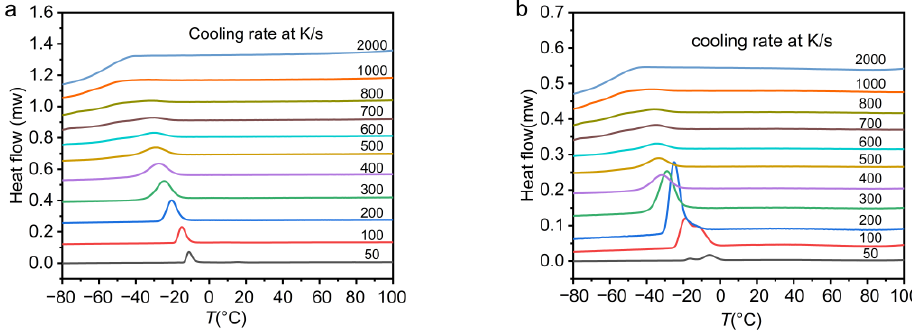
Figure 2. ( a ) PEG ( b ) PEG-PCL at different cooling rates of heat flow rate and temperature change cooling curve.